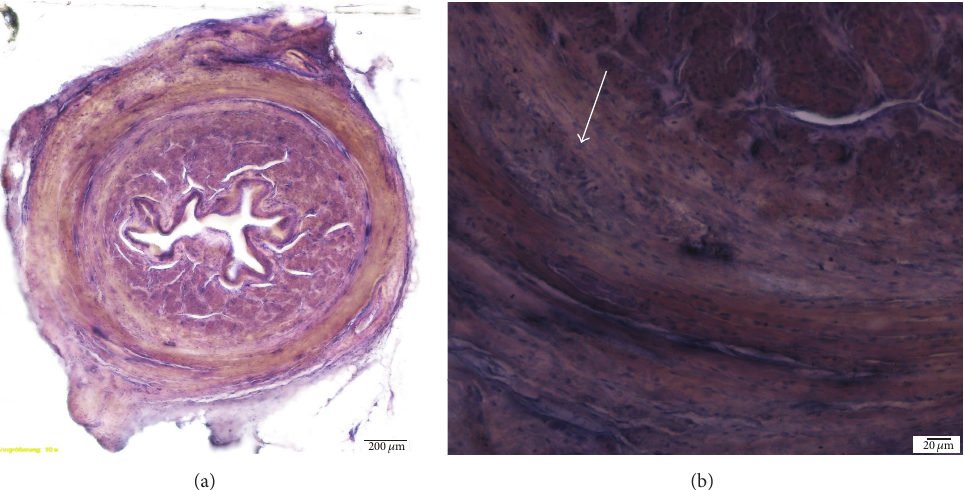
Figure 5: Cross-sections of urethra 5 months after injection of Bulkamid. (a) Cross-section of urethra without large injection mass (10x magnification). (b) Image showing small injection aggregates in a nodular type of reaction with mild surrounding fibroblastic changes (20x magnification). Arrow indicates bulking agent mass.